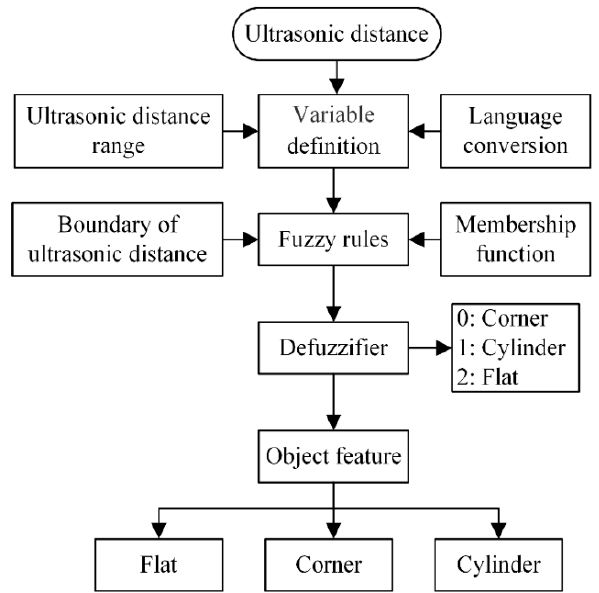
Figure 6. Procedure of fuzzy classification model.